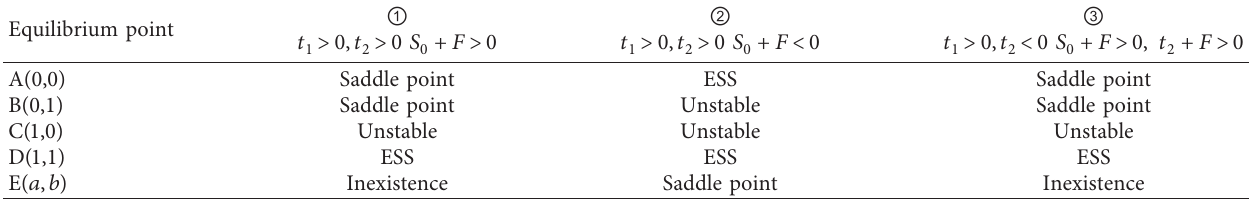
Table 7: Local stability of each equilibrium point in the range of different parameter values.